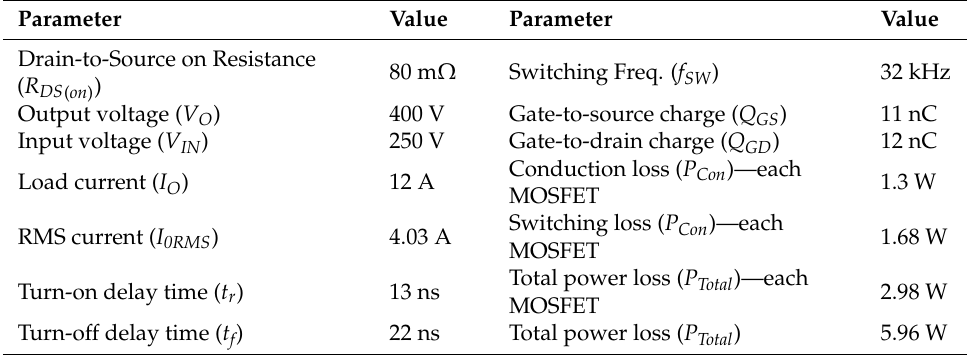
Table 3. MOSFET Parameters and calculated